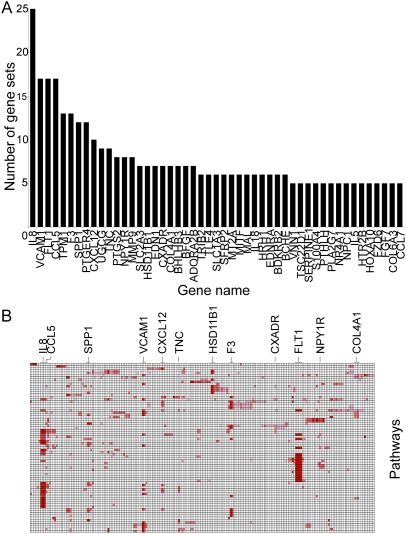
Gene Set Enrichment Analysis Validates the Hypothesis that the Golden Retriever Hemangiosarcoma Gene Set Is Involved in Hypoxia, Inflammation, and Cancer.A. Bar graph representing the number of gene sets/pathways from the GSEA archived database that were enriched in hemangiosarcoma samples from Golden Retrievers versus hemangiosarcoma samples from non-Golden Retrievers. Each gene on the x-axis was present in the number of GSEA gene sets indicated on the y-axis (of 77 where FDR<0.05). B. Graphical representation of genes (x-axis) present in each GSEA pathway/gene set (y-axis), where a filled box means the gene was present and enriched in that GSEA pathway. Increasing red intensity reflects higher enrichment scores. The genes enriched in the highest number of gene sets are identified by name.